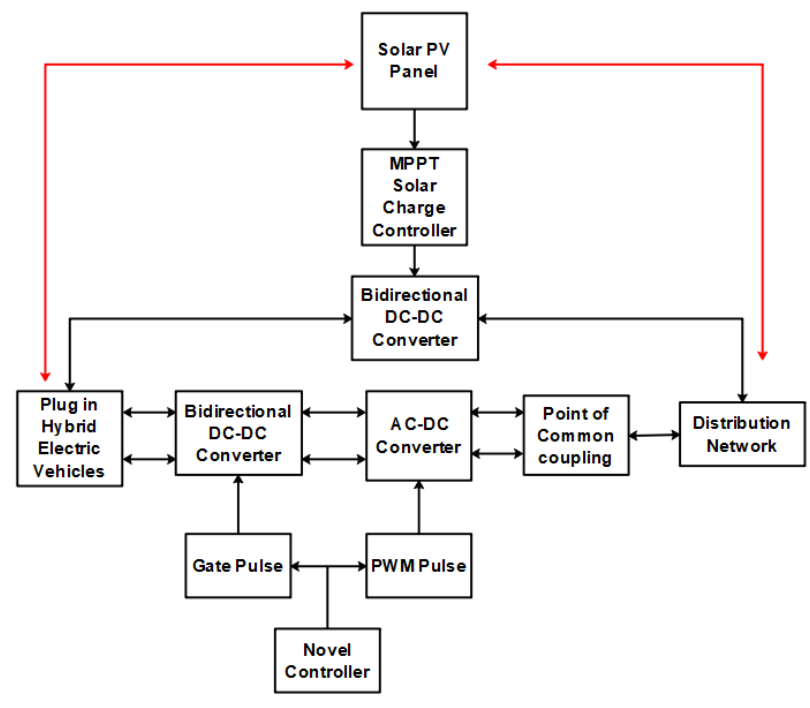
Figure 5. Process of PV-Grid-EV.